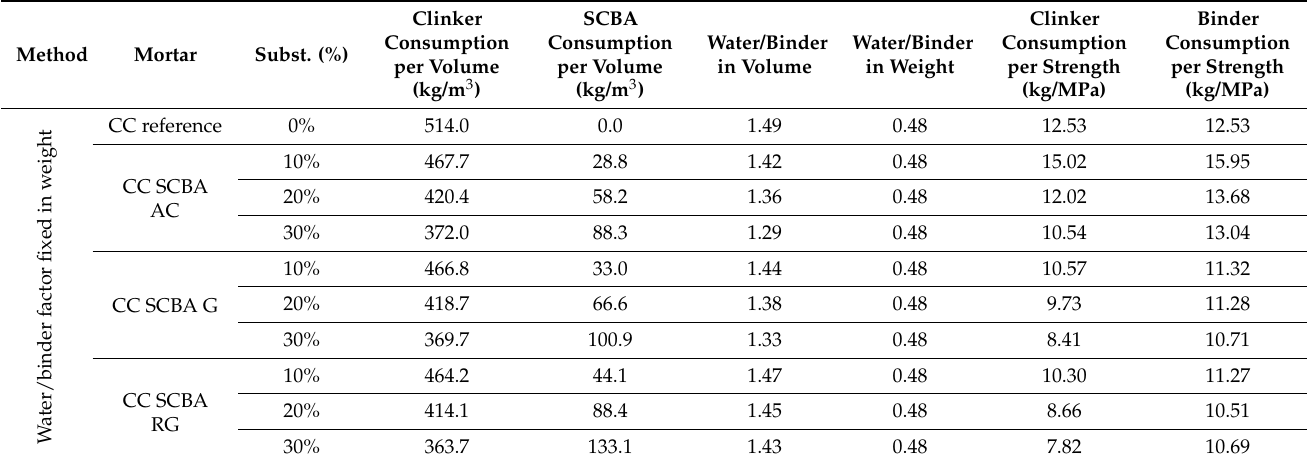
Table 6. Comparisons between cement or agglomerate consumption due to compression strength of mortars with water/binder factor fixed in weight.